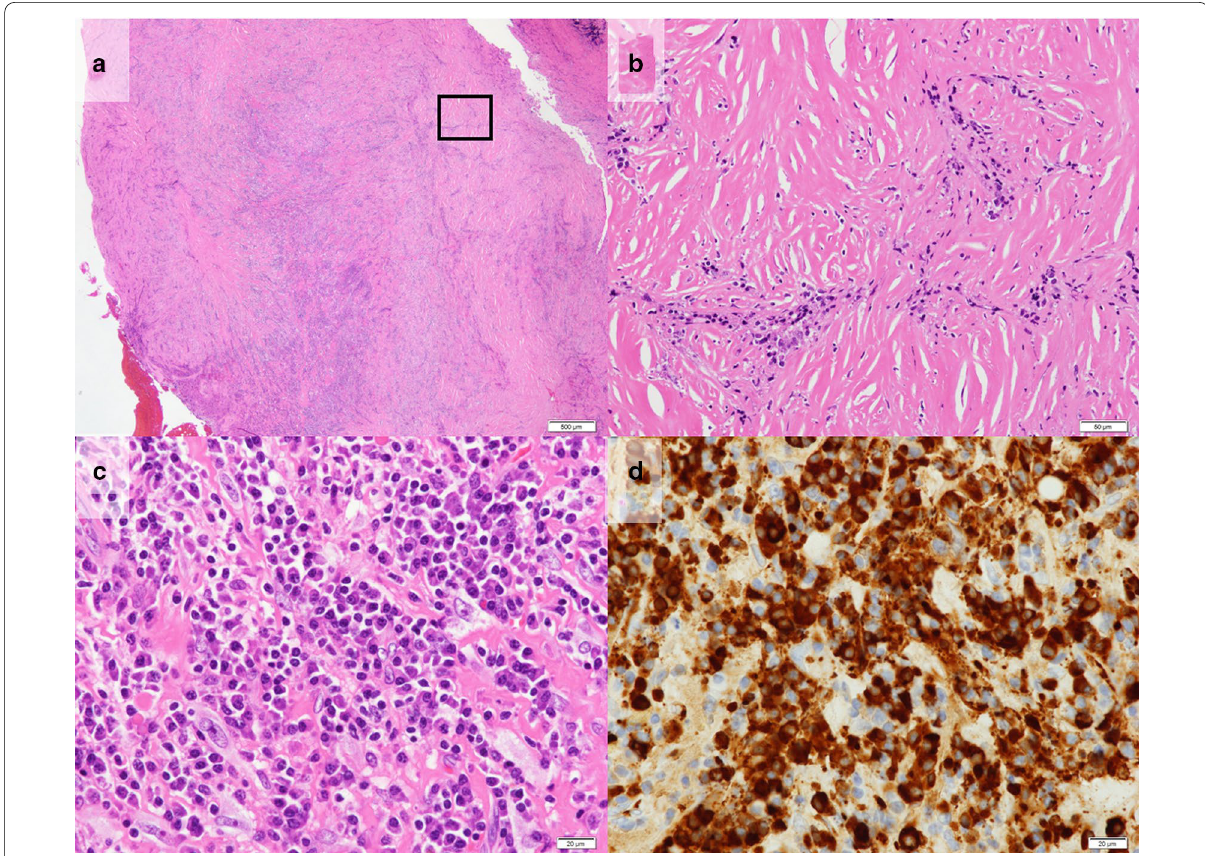
Fig. 2 Histopathological and immunohistochemical findings. The nodule consisting of hyalinized fibrous tissue, with a high degree of plasma cell-based inflammatory cell infiltration. A storiform pattern was observed in some parts of the fibrosis. Obstructive phlebitis was not apparent. a Hematoxylin and eosin (H&E) staining, 2 magnification. The black rectangle in ( a ) is the same area as shown in ( b ). b H&E staining, × magnification. c H&E staining, 40 magnification. d IgG4- positive plasma cells were conspicuous, accounting for 70.5% of ×